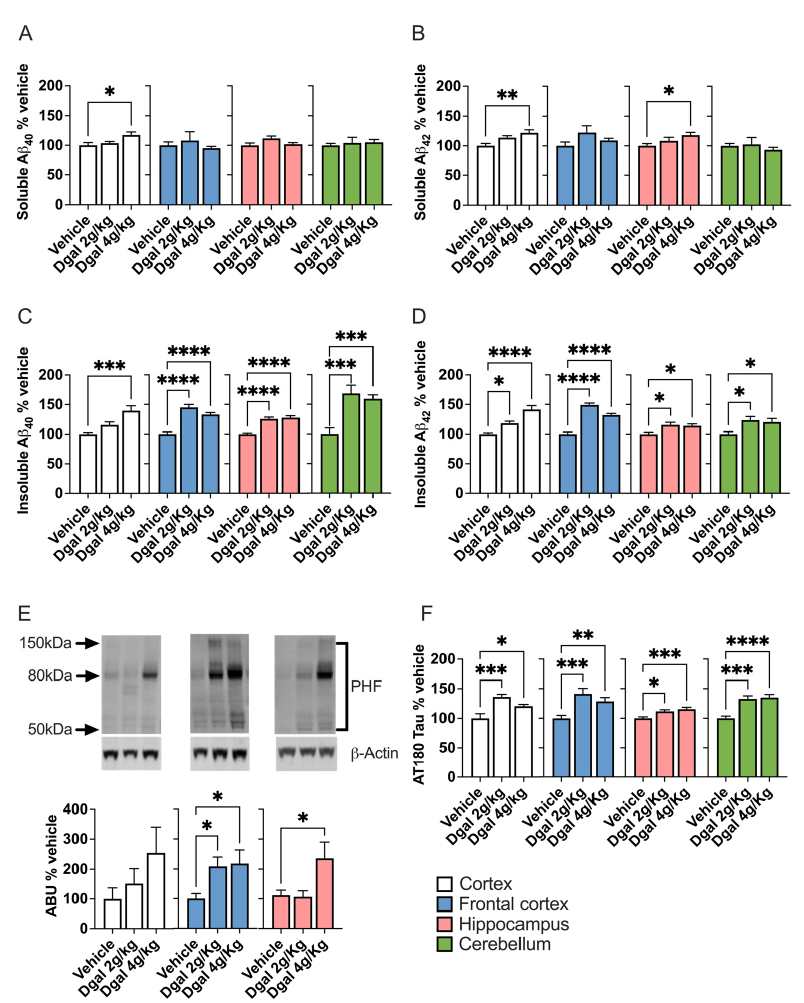
Figure 3. Chronic oDGal treatment promotes A β and hyperphosphorylated tau accumulation. ( A ) Soluble A β 40 in the cortex, frontal cortex, hippocampus, and cerebellar fractions of